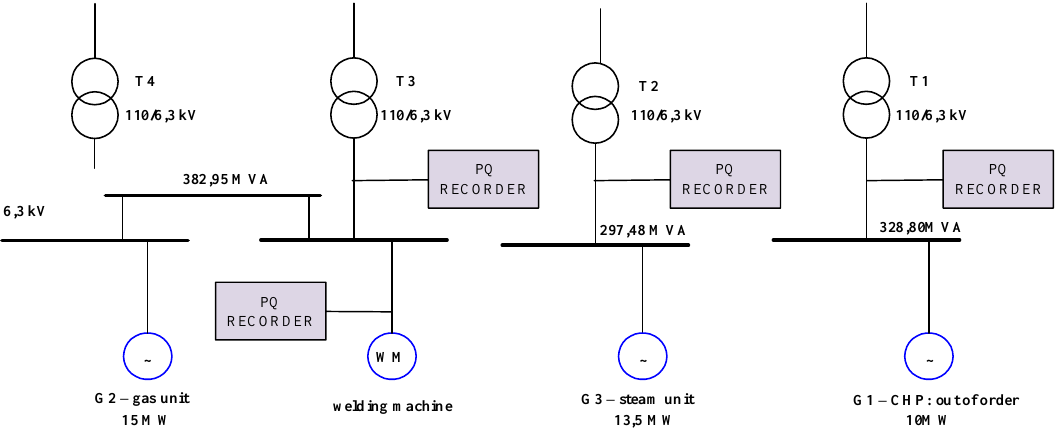
Figure 2. The simplified scheme of the electrical power network of the mining industry containing the placement of the PQ recorder and distributed generation.